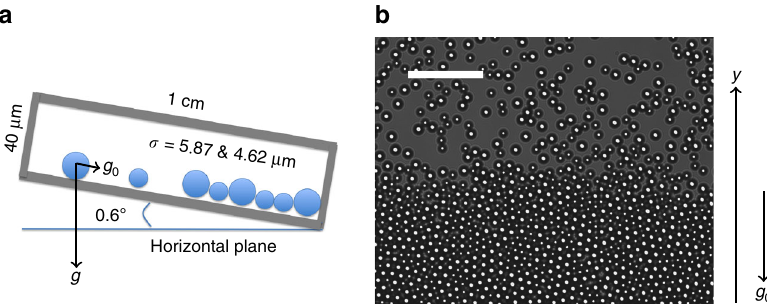
Fig. 1 A binary colloidal glass monolayer formed by vapor deposition (Supplementary Movie 1). a Schematic of the sample cell. b The colloidal glass grew along the y direction by vapor deposition under gravity. Scale bar : 50 μ